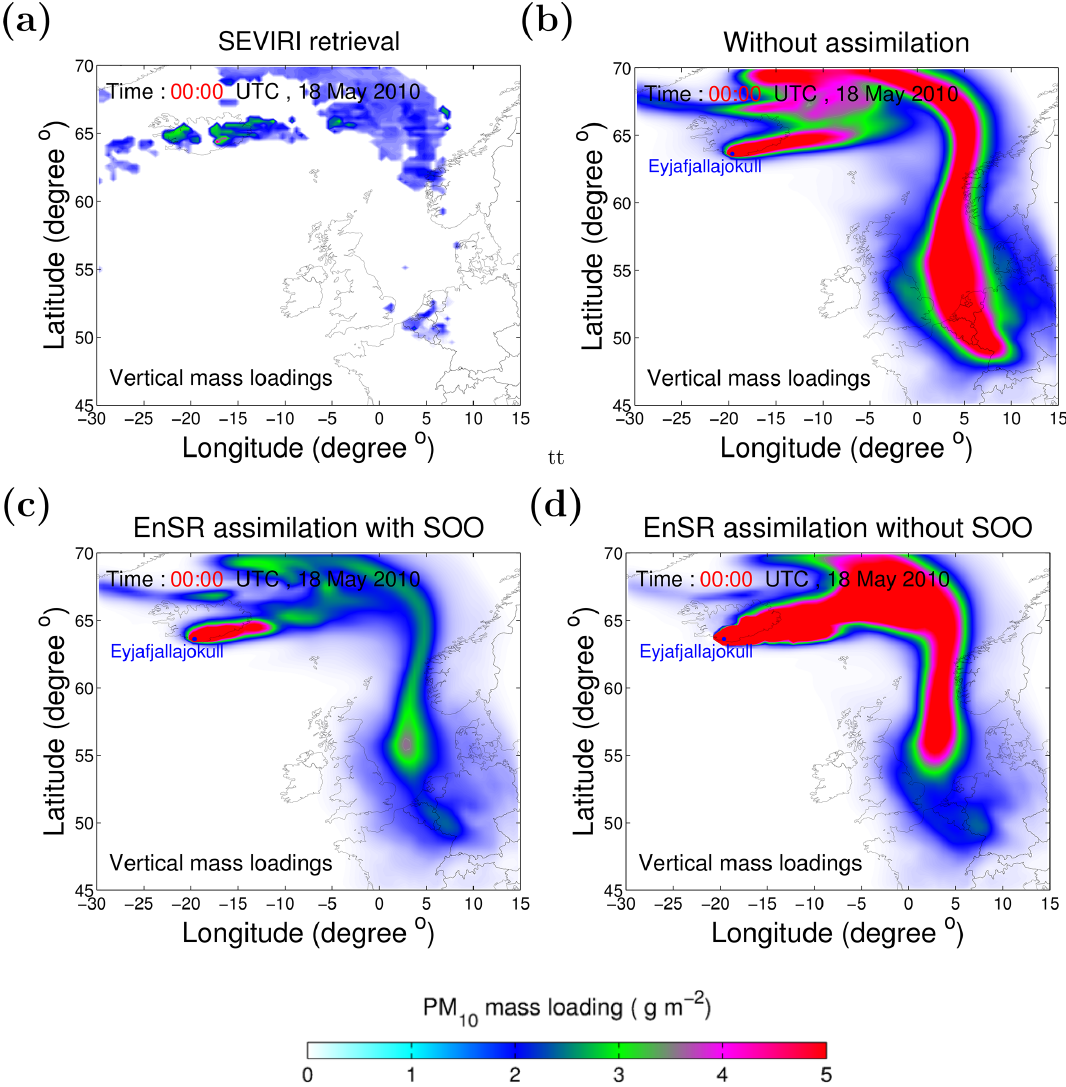
Figure 6. PM 10 mass loadings with EnSR against the SEVIRI retrieval at 00:00UTC 18 May 2010. (a) SEVIRI-retrieved mass loadings in the vertical direction, i.e., M v in Eq. (1). (b) Simulated mass loadings without assimilation. (c) Mass loadings (ensemble mean) by EnSR assimilation with SOO. (d) Mass loadings (ensemble mean) by EnSR assimilation without